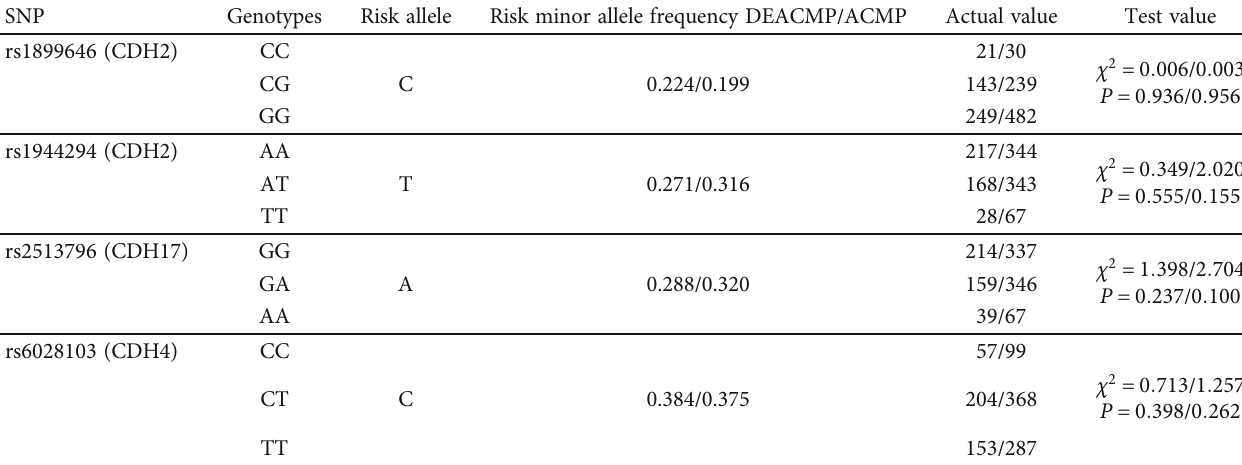
Table 3: Results of the Hardy-Weinberg equilibrium test for genotype distributions of cadherin polymorphisms.